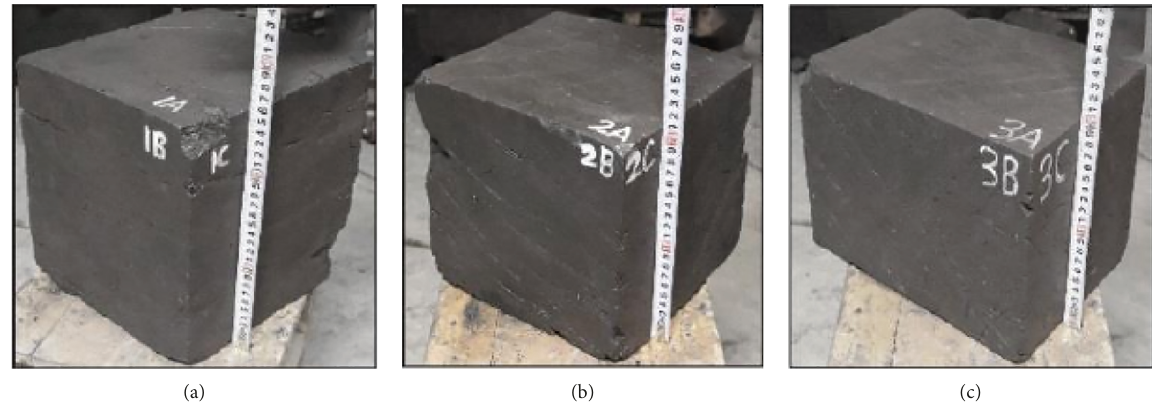
Figure 3: Photos of coal samples: (a) F1; (b) F2; (c) F3.